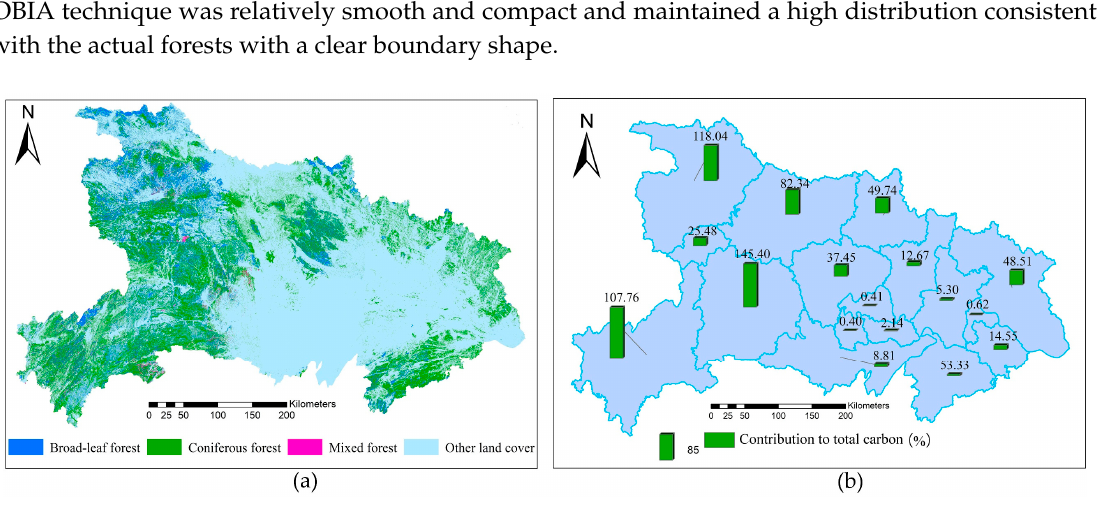
Figure 4. Spatial distribution of the forests ( a ) and forest carbon storage ( b